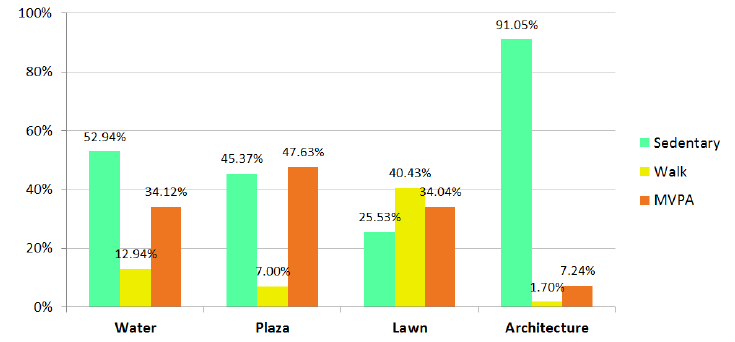
Figure 6. Percentage of observed park users by different landscape settings.